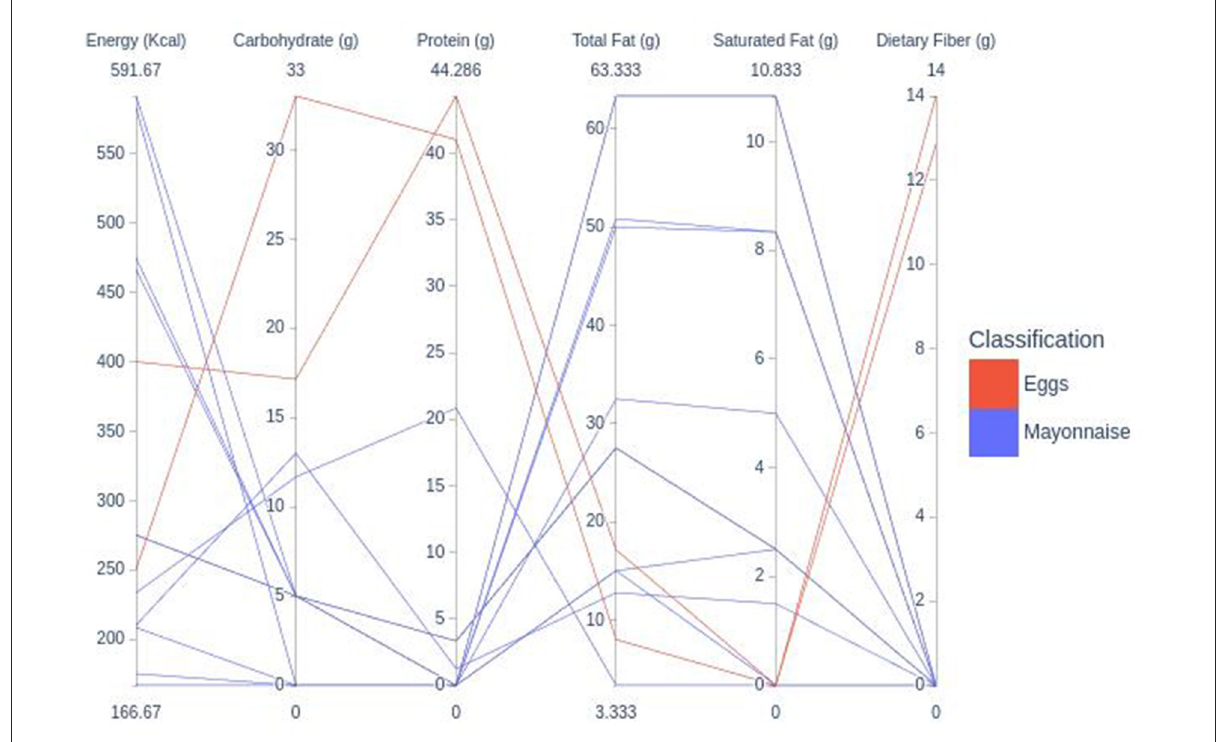
FIGURE2 Range of the nutritional values of the included egg substitutes.